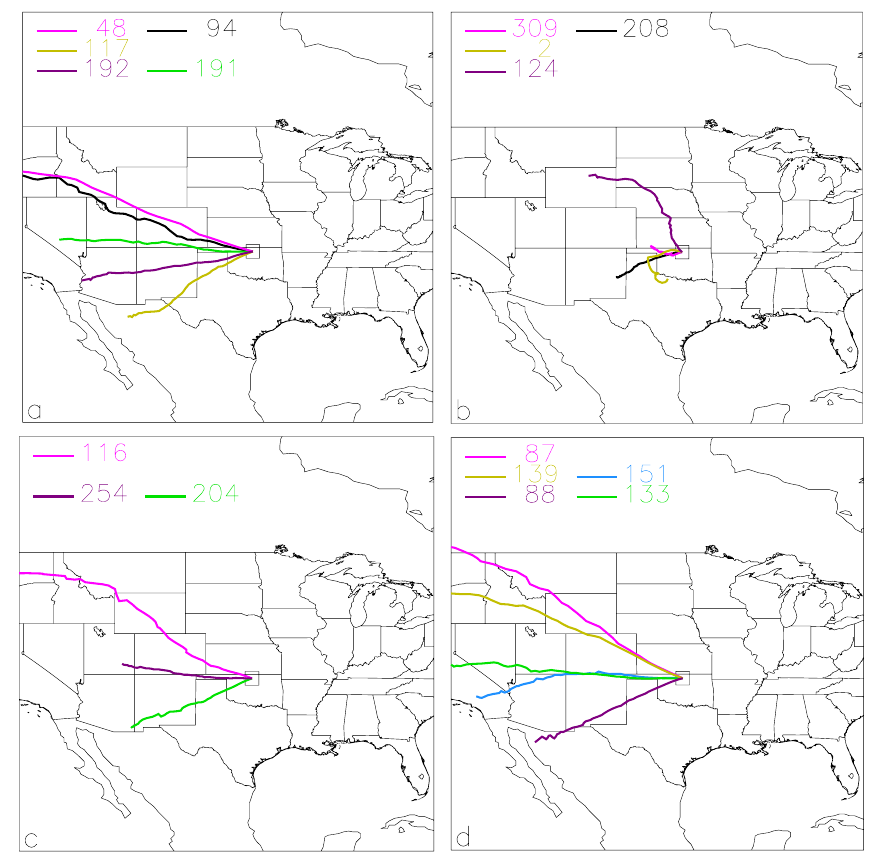
Fig. 5. Plots of air mass back trajectory clusters (cluster medians) arriving at 3000m to the profile site (indicated by the square) calculated using NOAA/HYSPLIT 4 1 ; (a) Spring (b) Summer (c) Fall (d) Winter. Numbers indicate how many trajectories are in each cluster. A maximum of 6 clusters was allowed. 1 Trajectories were generated using HYSPLIT 4 downloaded from: www.arl.noaa.gov/ready/hysplit4.